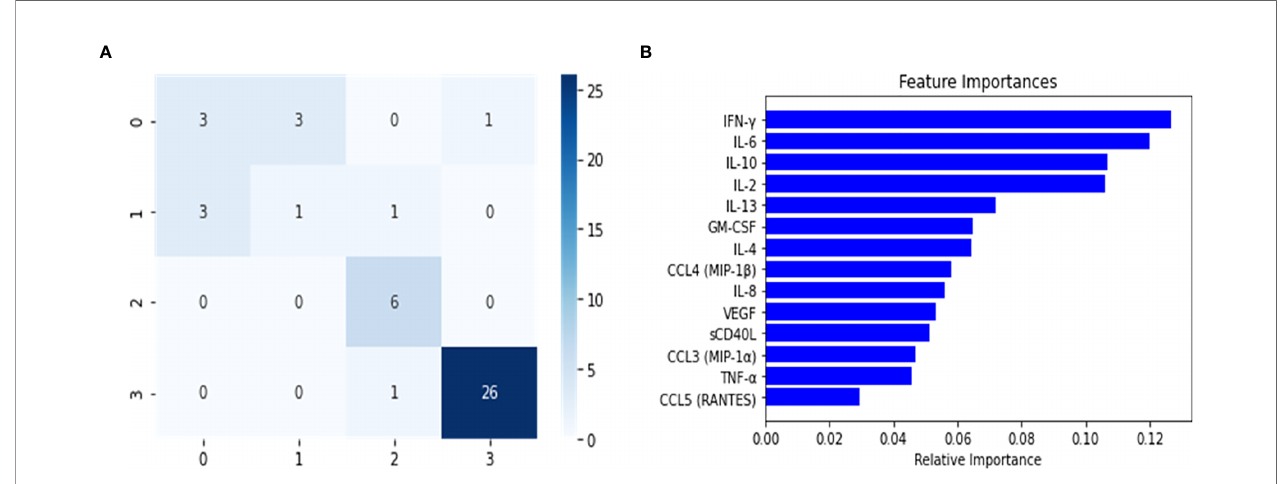
FIGURE 2 | Confusion Matrix (A) and Feature importance (B) for multi-class classi fi er using Random Forest predictor. The confusion matrix was calculated from the predictions of the random forest classi fi er on the test set. The classes were assigned in the following manner: (0) healthy controls, (1) Mild-Moderate, (2) Severe and (3)